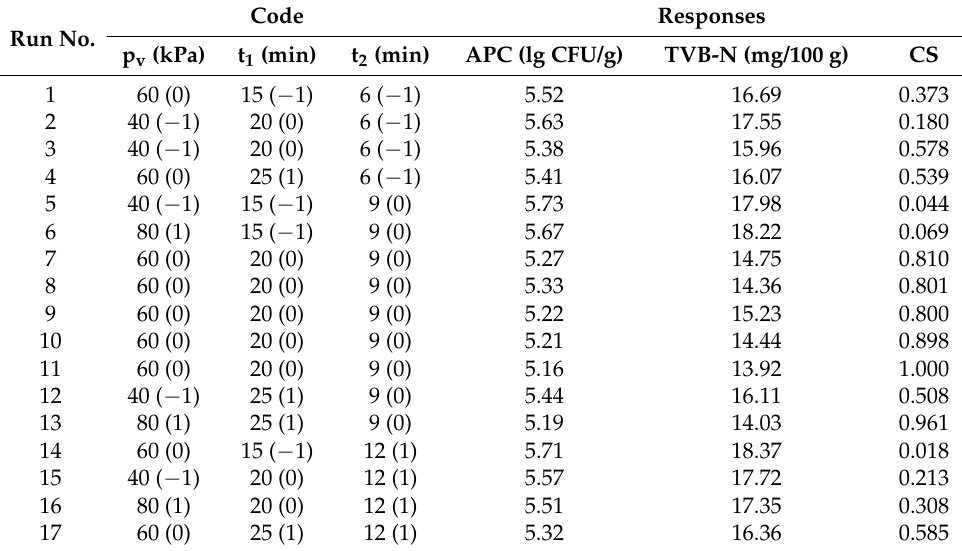
Table 3. Box–Behnken design with the independent variables p v , t 1 , and t 2 in their original and coded forms and results for APC, TVB-N, and